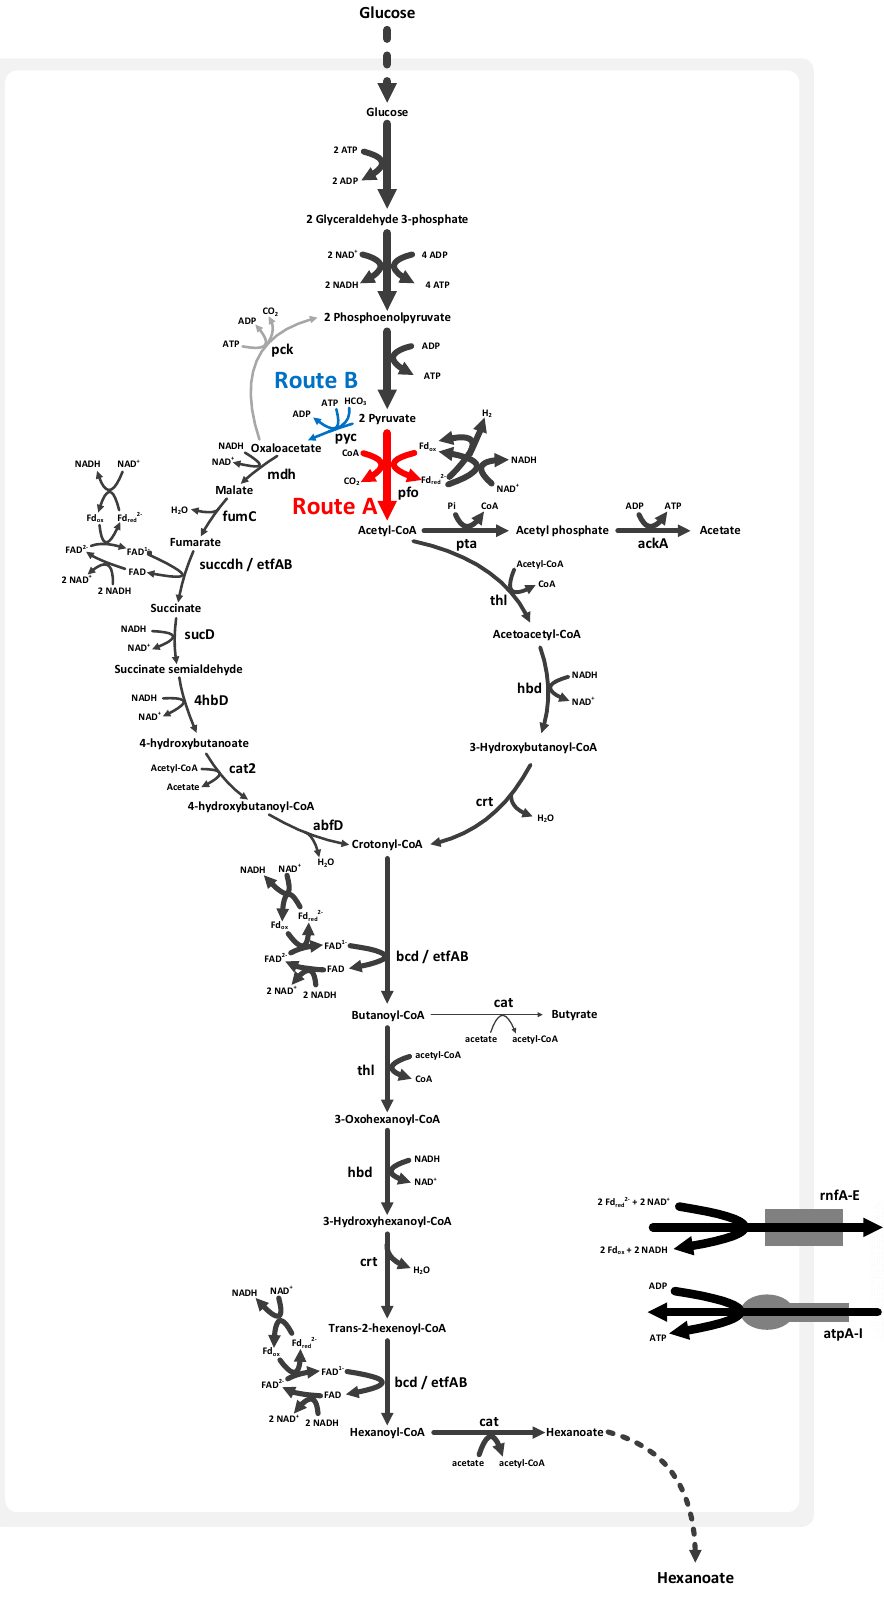
Figure 2. Bifurcated pathway to synthesize hexanoic acid in M. elsdenii . A fatty acid synthetic pathway starts from Route A through acetyl-CoA, or Route B via oxaloacetate, by running the tricarboxylic acid (TCA) cycle in a reductive direction. The thickness of the arrows represents flux values when maximizing hexanoic acid production from glucose.